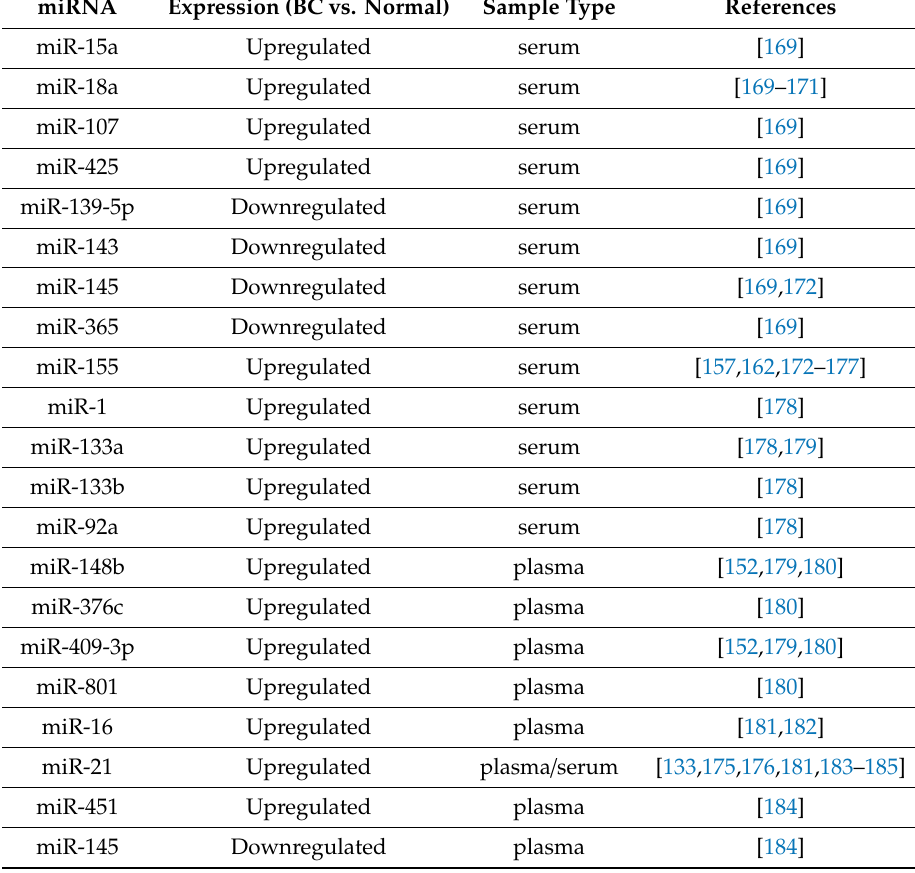
Table 2. Circulating miRNAs associated with BC screening approach. miRNA Expression (BC vs.